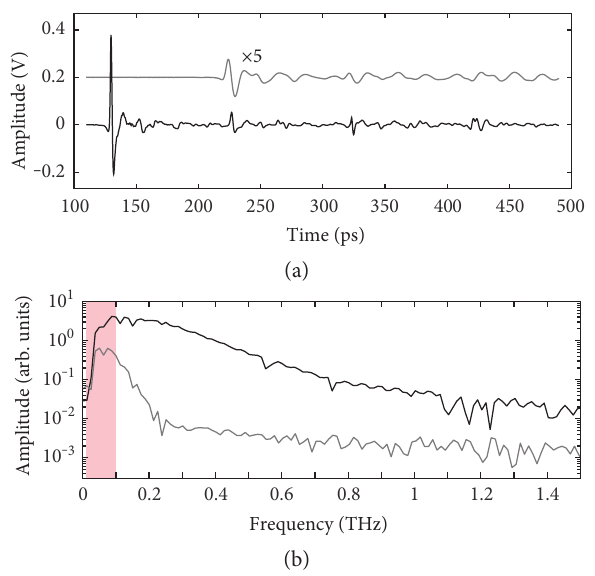
Figure 2: Example THz signals produced by the THz-TDS apparatus. (a) Time-domain comparison of a thru-air THz waveform (lower, black) and a thru-tile waveform (upper, gray). The thru-tile signal has been o ff set and magni fi ed × 5 for clarity. (b) Log scale frequency domain comparisons corresponding to the thru-air (black) and thru-tile (gray) waveforms. The 0.01 to 0.10 THz frequency band used for the transmission image has been highlighted in